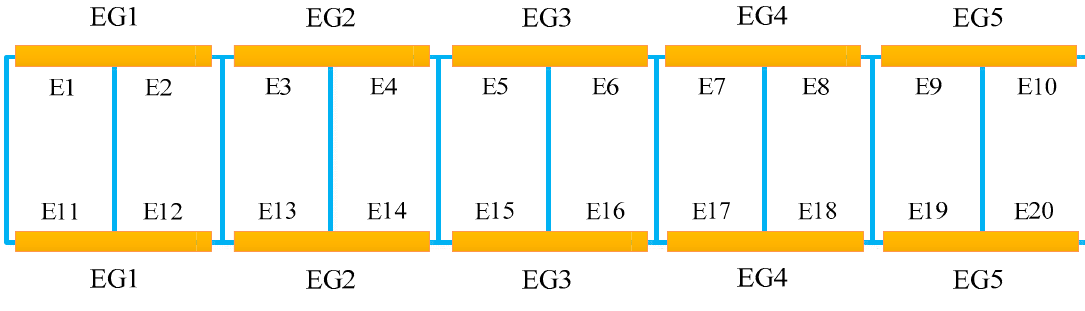
Figure 4. Configuration of element groups for generating training data. Table 2. Definition of element groups for the steel truss bridge